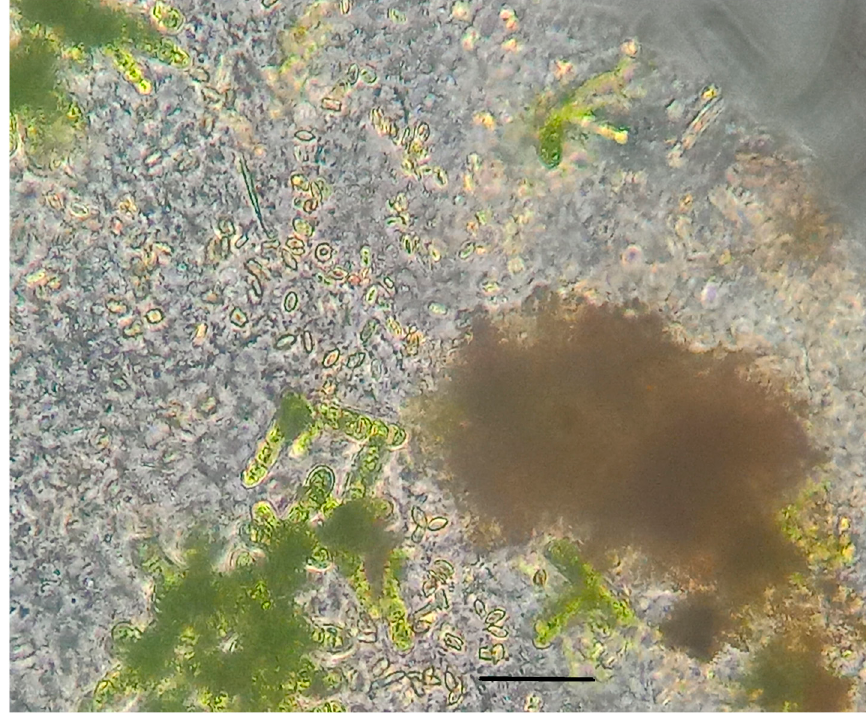
Figure 8. A section of the mucilage sample taken from Kalamis, Istanbul, on 11 June 2021, shows green microalgal species and the pennate diatom Nitzschia amabilis (small oval cells ); scale is 50 µm.